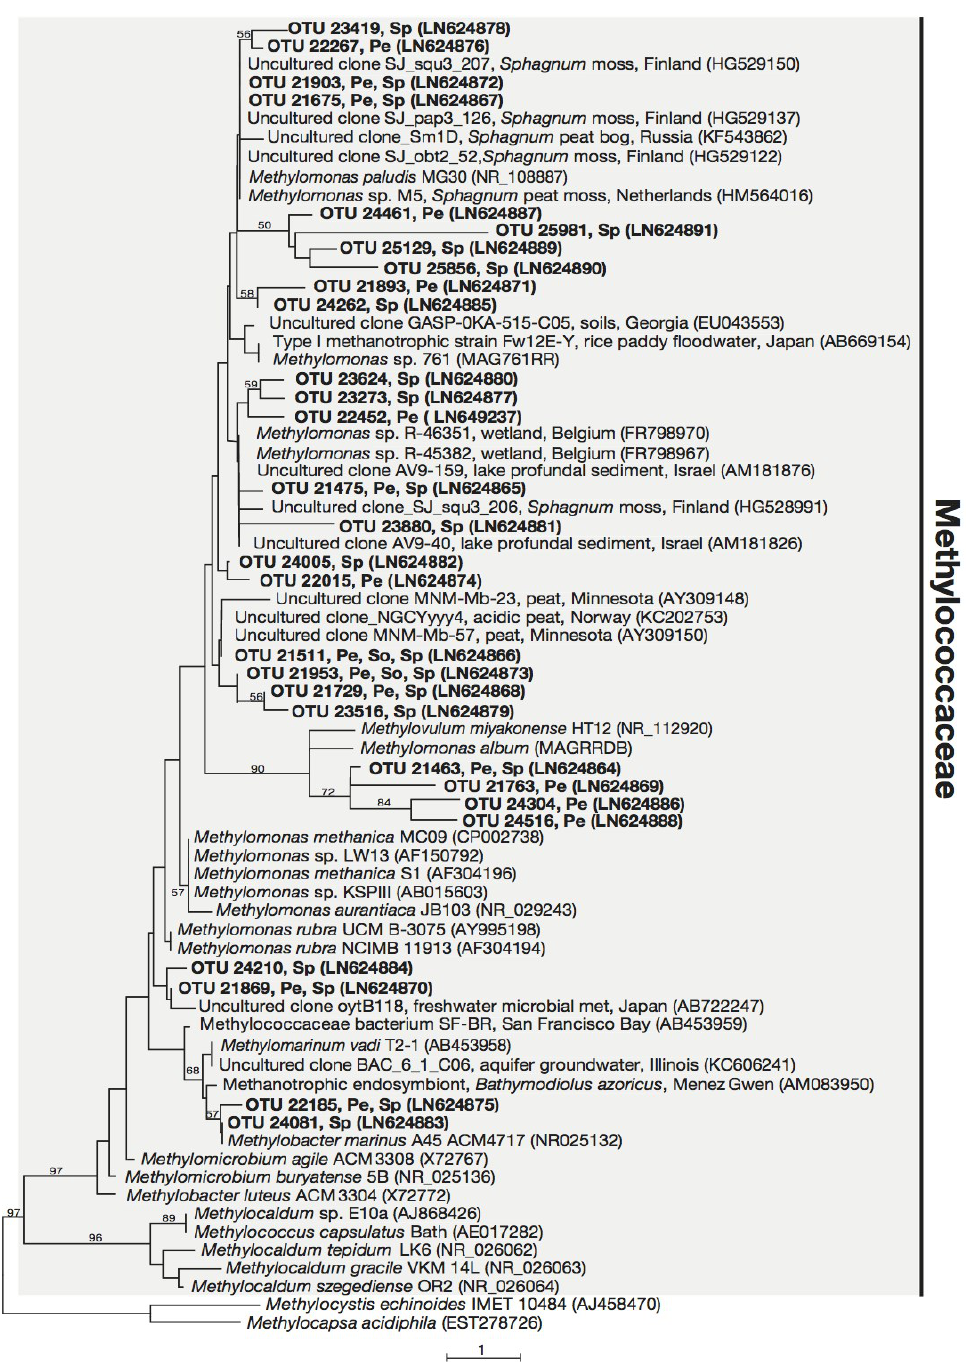
Figure 1. Phylogenetic tree based on maximum parsimony (MP) analysis of twenty-nine OTUs (~193 bp) detected in this study (in bold) in comparison with their close relatives and representatives from the Methylococcaceae. The locations where these OTUs were detected are indicated: Pe, peat; So, forest soil; Sp, Sphagnum moss. Bootstrap values from 1000 replicates are indicated at the nodes of branches (if > 50). The scale bar represents the number of nucleotide